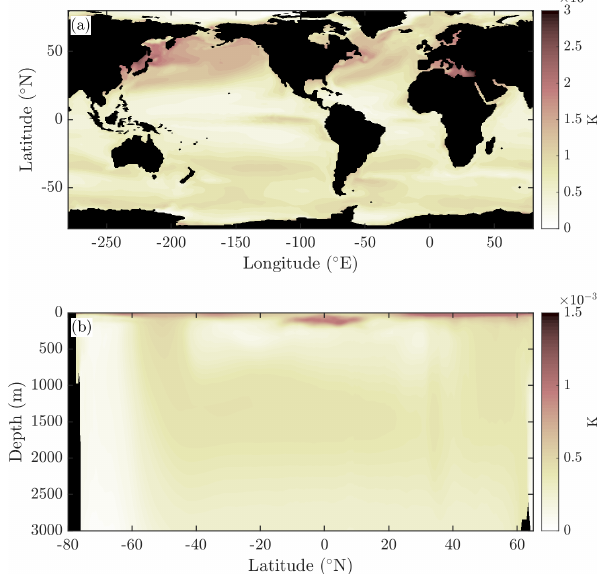
Figure 9. The RMSE (K) in evaluating Conservative Temperature from the CMIP6 archived monthly averaged values of potential tem- perature and salinity compared with averaging the instantaneous values of Conservative Temperature for a month at the (a) sur- face and (b) the zonal mean. These quantities are calculated from 50 years of temporally averaged output from the ACCESS-CM2 model’s pre-industrial control simulation. The errors are seen to be no larger than a few millikelvin